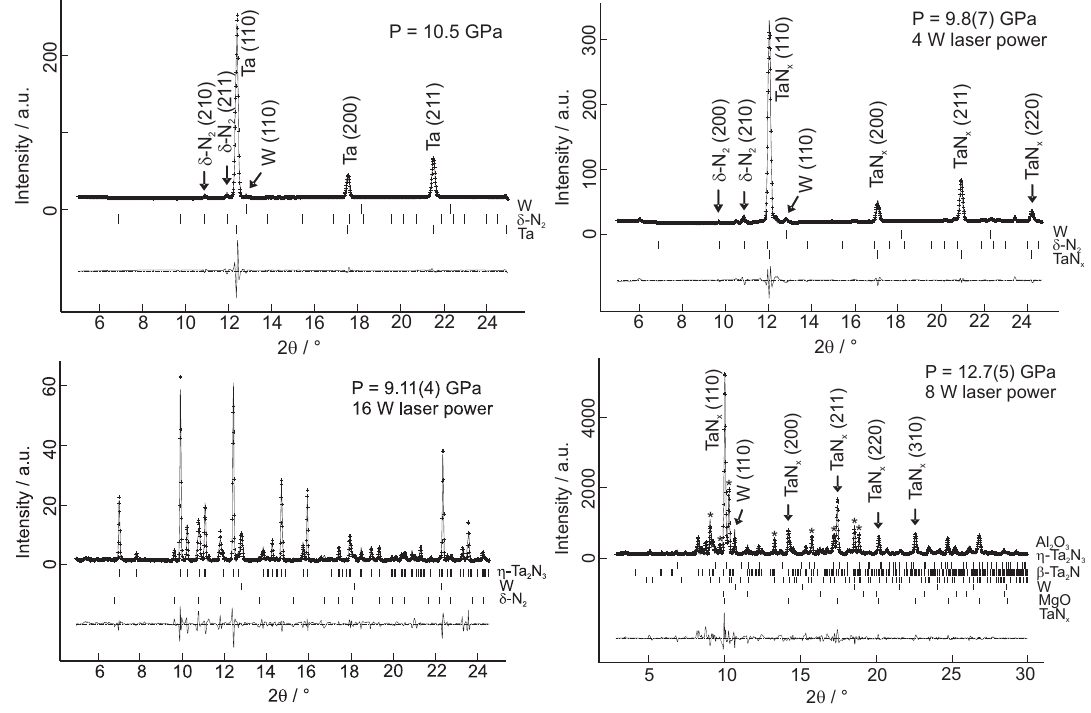
Refined powder X-ray diffraction patterns ( λ = 0.4958 ˚ A) for the unreacted tantalum foil at 10.5 GPa (top left), the TaN after laser alignment (top right), and the fully x reacted η -Ta N after strong laser heating at 9 GPa (bottom left) [56]. Bottom right: Refined 2 3 powder X-ray diffraction pattern ( λ = 0.4132 ˚ A) for another reacted tantalum sample, where after laser alignment at 12.7(5) GPa the formation of TaN , β -Ta N (reflections marked by x 2 stars) and a small amount of η -Ta N was observed [56]. Diffraction lines of tungsten stem 2 3 from the